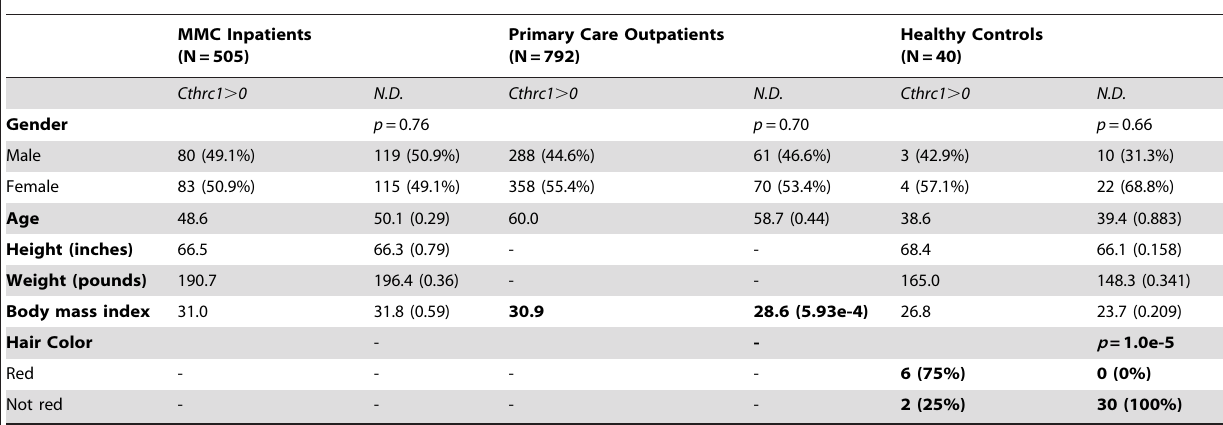
Table 2. Univariate association of demographic variables with